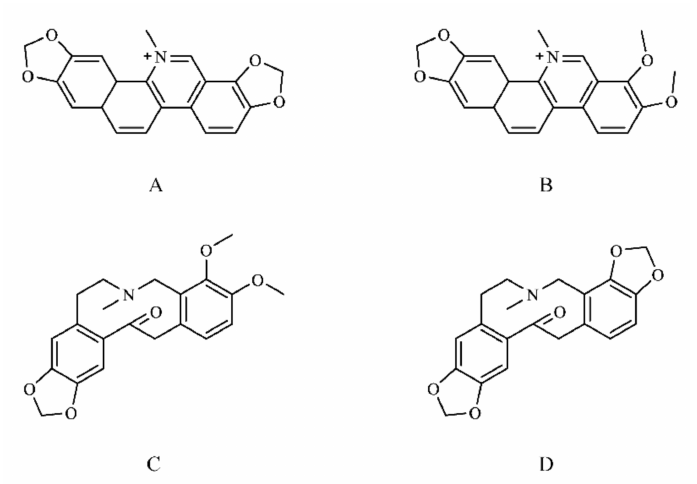
Figure 1. Chemical structures of the candidate compounds. ( A ) Sanguinarine; ( B ) Chelerythrine; ( C ) Allocryptopine; ( D )